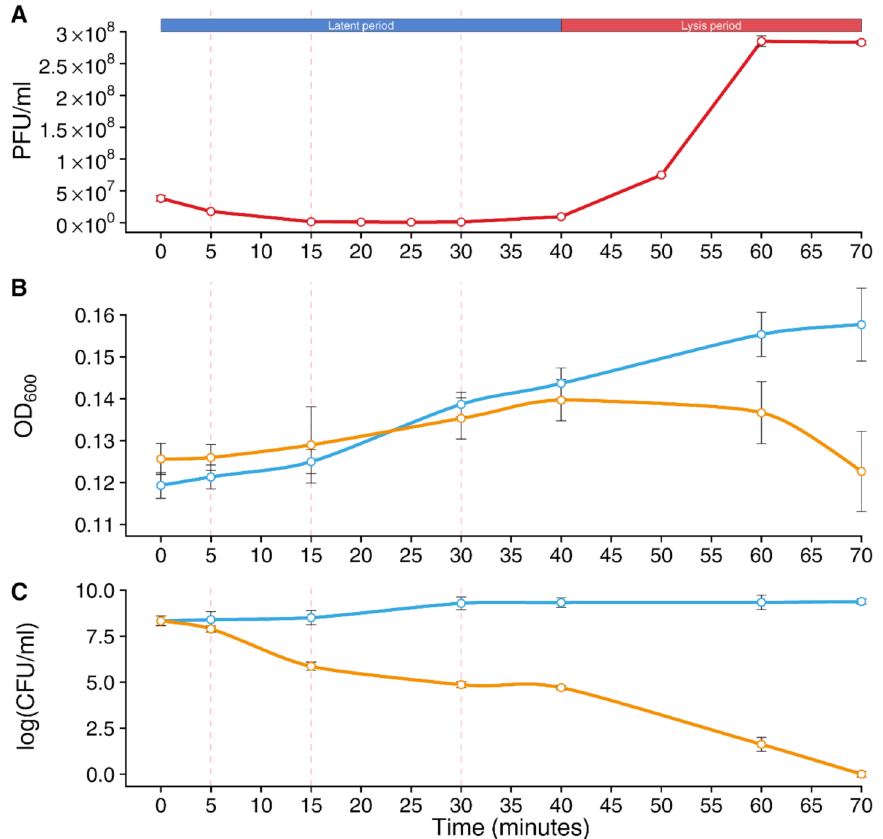
Figure 1. Analysis of the replication cycle of a bacteriophage and its effect on the bacterial growth. ( A ) The one-step growth curve of vB_SauM-515A1 bacteriophage, modified from [25]. ( B , C ) Growth inhibition curves of SA515 strain by the vB_SauM-515A1 phage. Phage-mediated lysis of bacteria was monitored by measuring the OD 600 values and colony-forming units/mL (CFU/mL) throughout the infection. The blue color corresponds to uninfected cells of SA515 strain, and yellow to phage-infected cells. Dotted lines indicate the three sampling time points selected for the transcriptomic